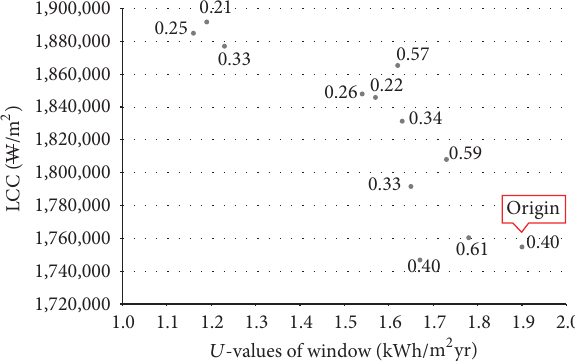
Figure 3: LCC according to the window performance.